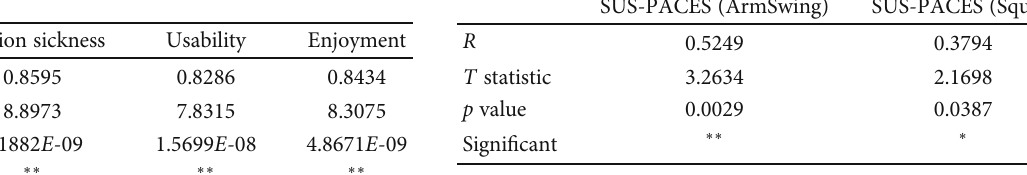
Figure 7: Results from the interview with questions about preference and playing time. Table 5: The association by the Pearson correlation coe ffi cient Table 4: The association by the Pearson correlation coe ffi cient between SUS and PACES scores of the ArmSwing and the between ArmSwing and Squat in terms of motion sickness, usability, and enjoyment ( ∗ signi fi cant p < 0 : 05 , ∗∗ highly signi fi cant p < 0 : 01 ).